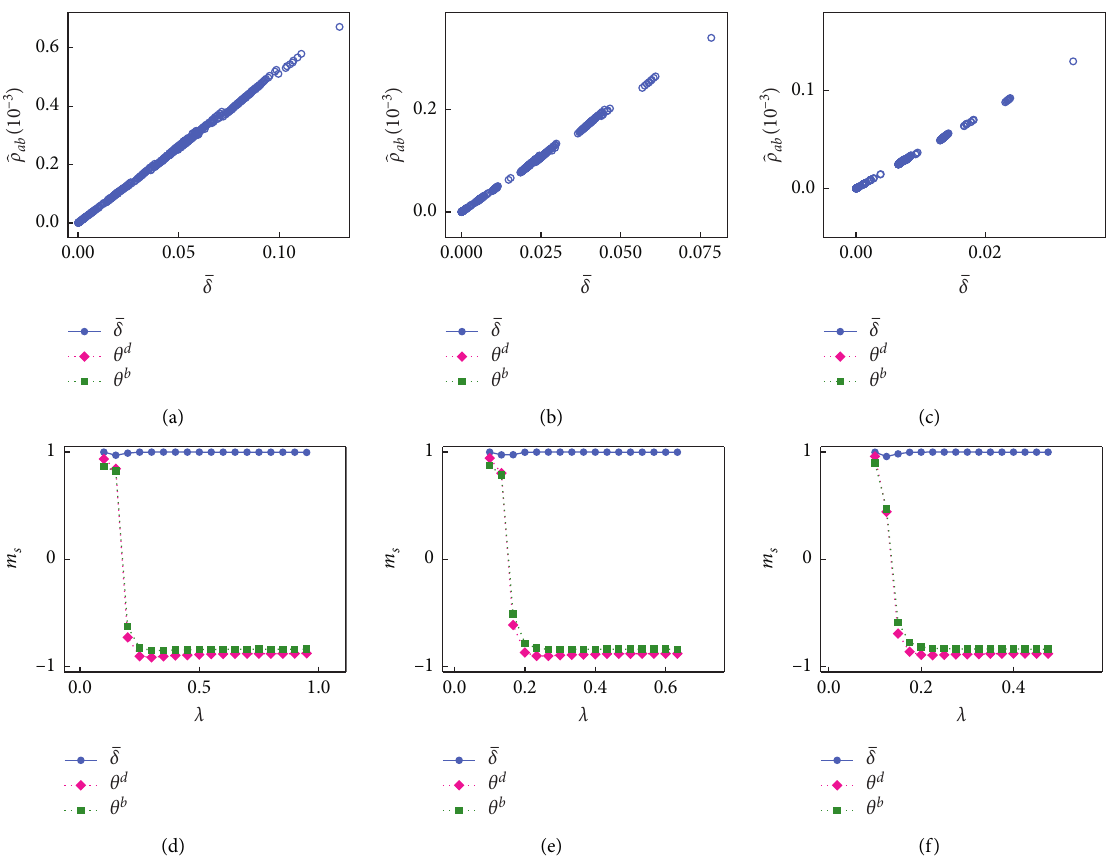
Figure 1: The correlation between influence indicator δ and incremental cooperative spreading prevalence 􏽢 ρ δ when the cooperativity parameter (a) β � 1, (b) β � 1 . 5, and (c) β � 2. The Spearman rank correlation m s between 􏽢 ρ ab and δ (blue circles), product θ d (pink diamonds), or θ b (green squares) versus λ when (d) β � 1, (e) β � 1 . 5, and (f) β �